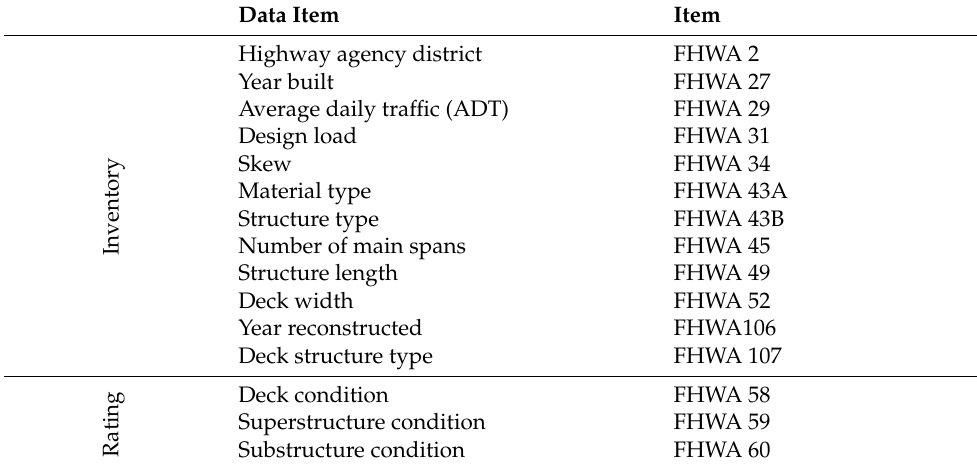
Table 2. Description of FHWA